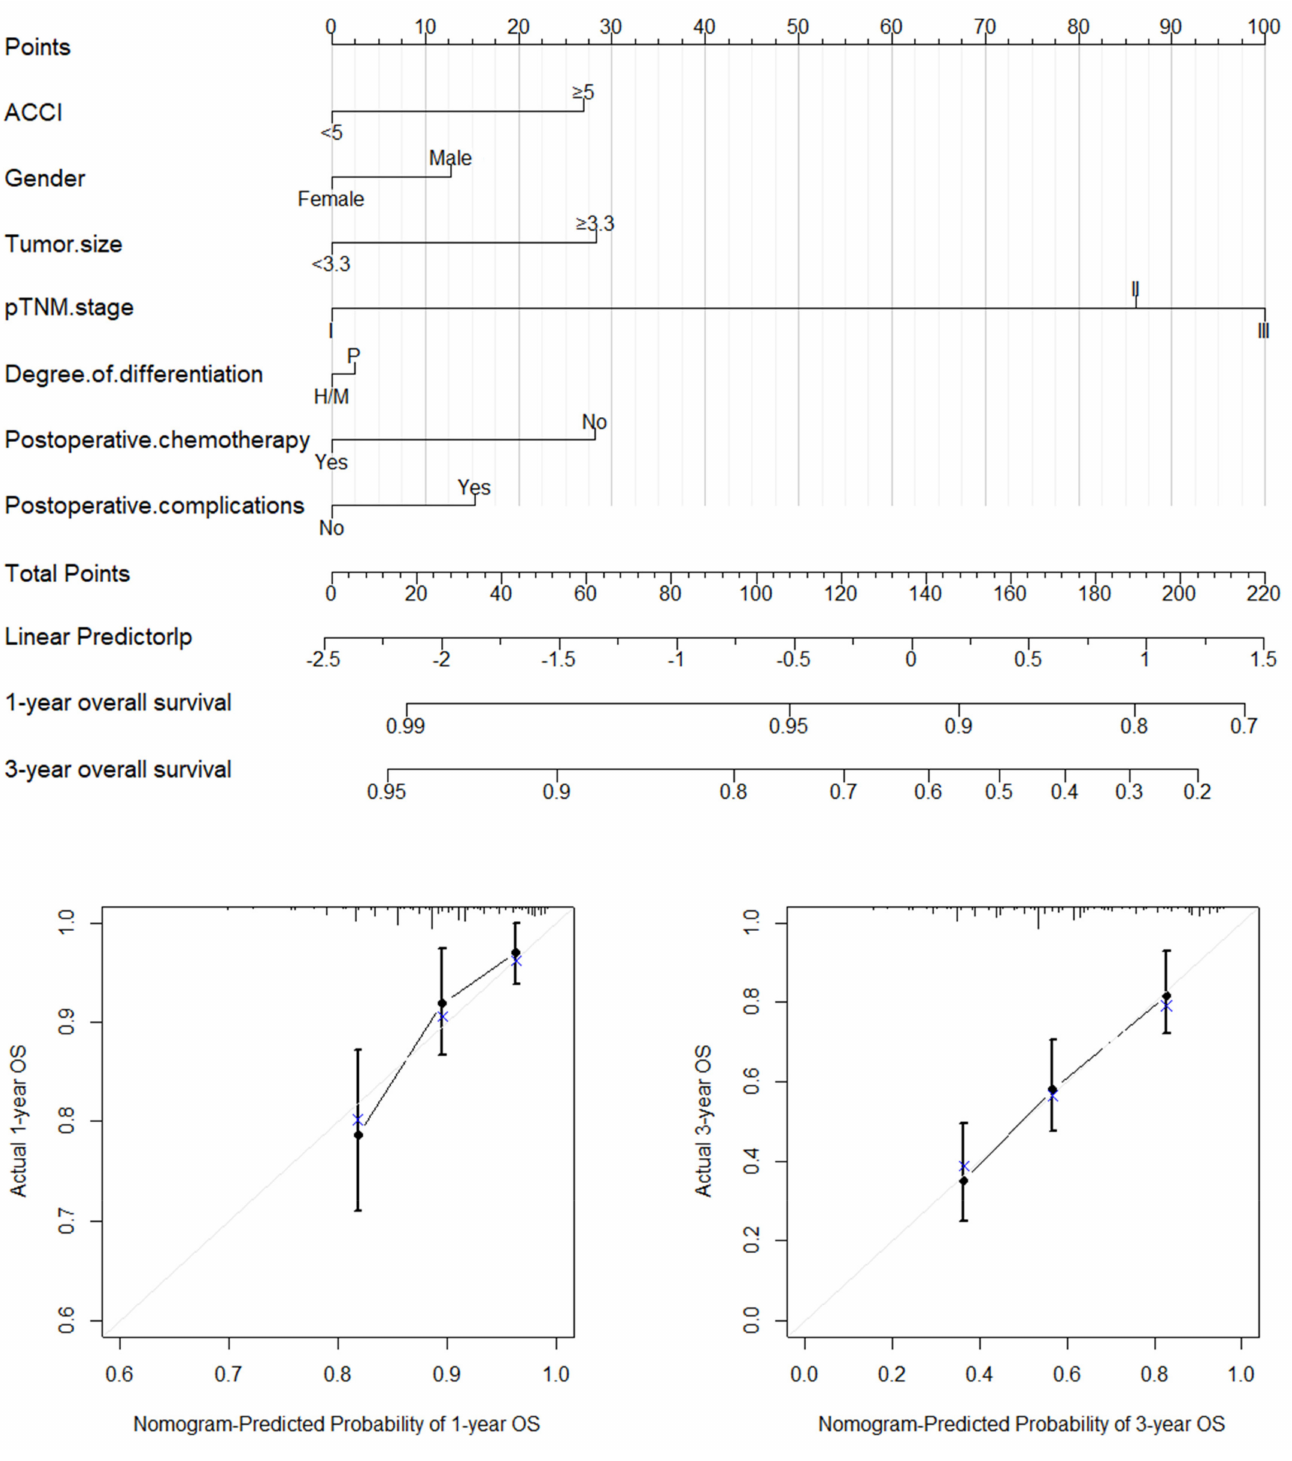
Figure 2. Nomogram plot and calibration curves of the 1 − year and 3 − year